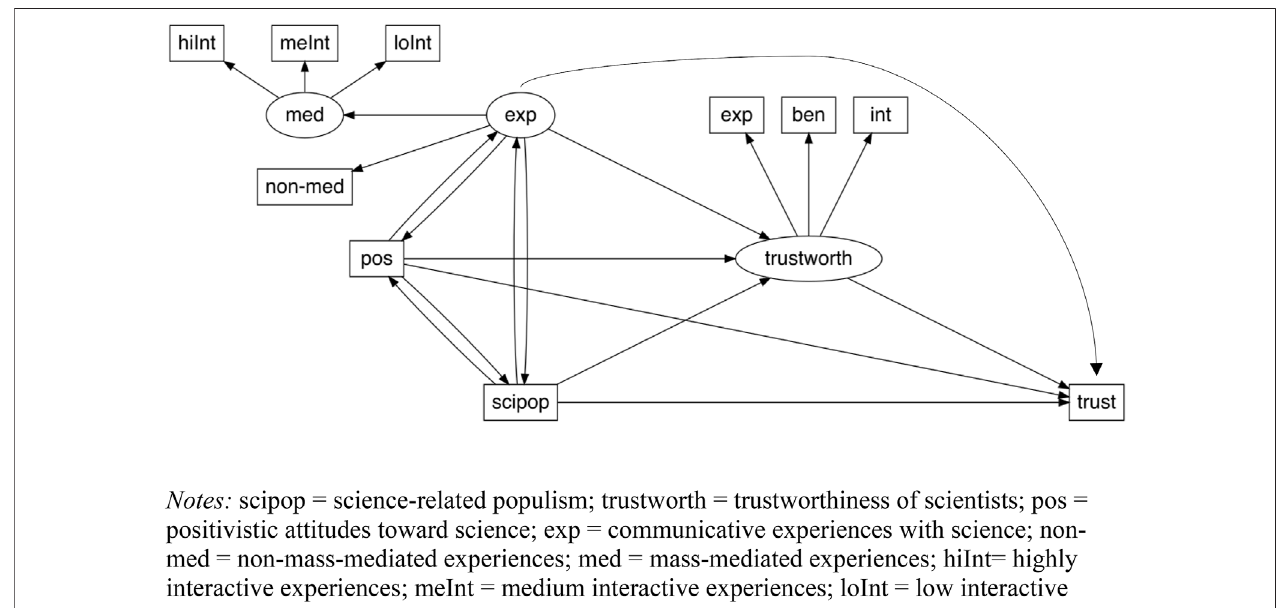
FIGURE 2 | Structural equation model. Notes : scipop (cid:1) science-related populism; trustworth (cid:1) trustworthiness of scientists; pos (cid:1) positivistic attitudes toward science; exp (cid:1) communicative experiences with science; non-med (cid:1) non-mass-mediated experiences; med (cid:1) mass-mediated experiences; hiInt (cid:1) highly interactive experiences; meInt (cid:1) medium interactive experiences; loInt (cid:1) low interactive experiences.